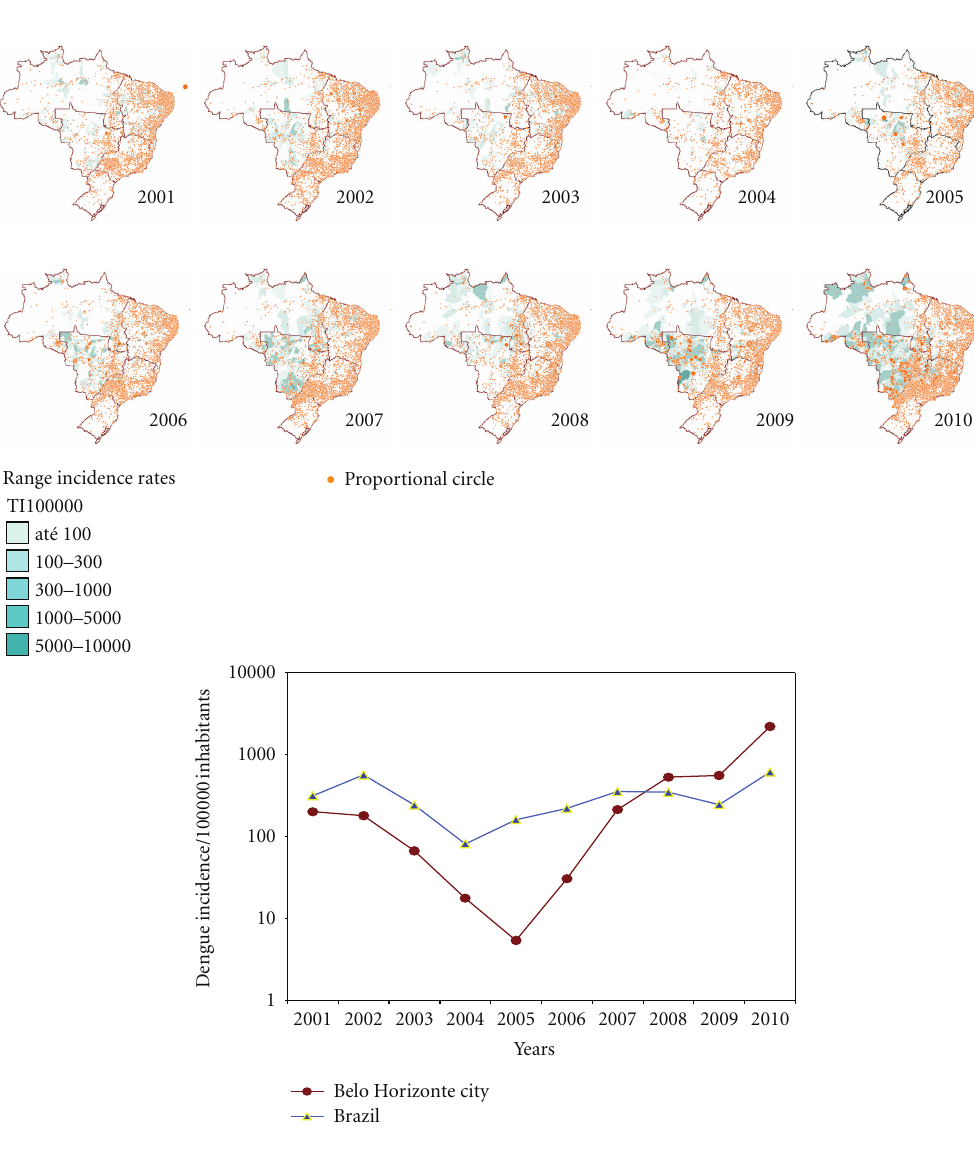
Figure 3: Dengue incidence point maps by city (proportional circle) and range incidence rates by municipalities areas, temporal dynamics in space, Brazil, and incidence years comparative graphic, Belo Horizonte city, Brazil,